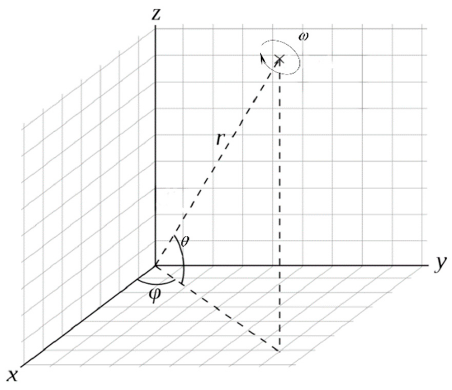
Figure 8. The camera position and orientation are described by distance to the object origin r , two rotation angles: azimuthal ϕ , zenith θ , and camera rotation angle ω